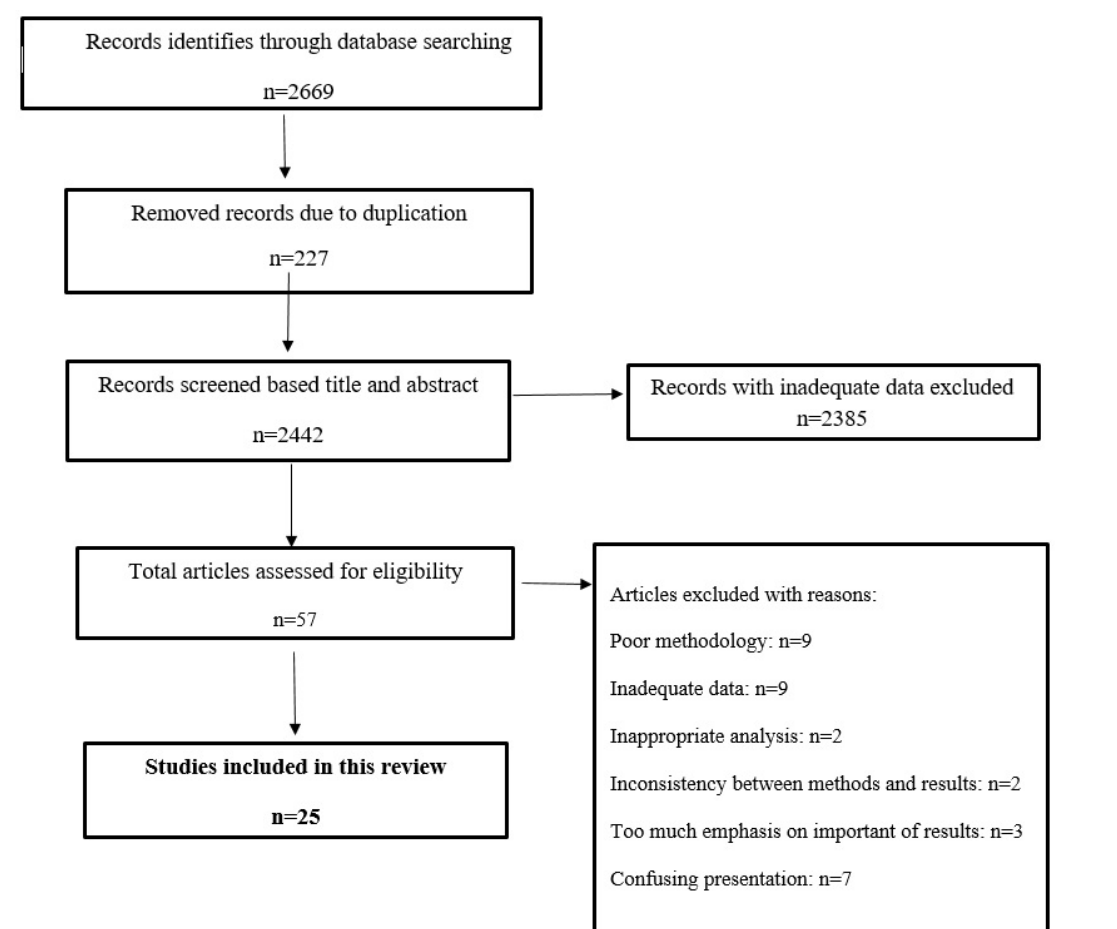
Figure 2. Flowchart describing the study design process.